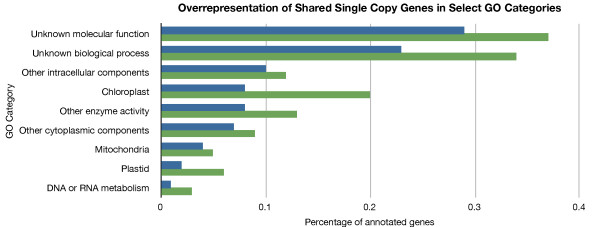
Overrepresentation and underrepresentation of shared single copy genes in select GO categories. Bar chart showing GO slim categories that are overrepresented in the APVO PlantTribes using the TAIR8 annotation of the Arabidopsis thaliana genome using an initial alpha value of 0.05 with a subsequent Bonferroni correction for multiple tests. Bottom green bar represents percentage of APVO shared single copy genes with the given annotation; top blue bar is percentage of genes with the given annotation for the remainder of the genome. Overrepresentation and underrepresentation was detected using a chi-square test comparing the slim GO annotation of the single copy tribes versus all else in the Arabidopsis genome.